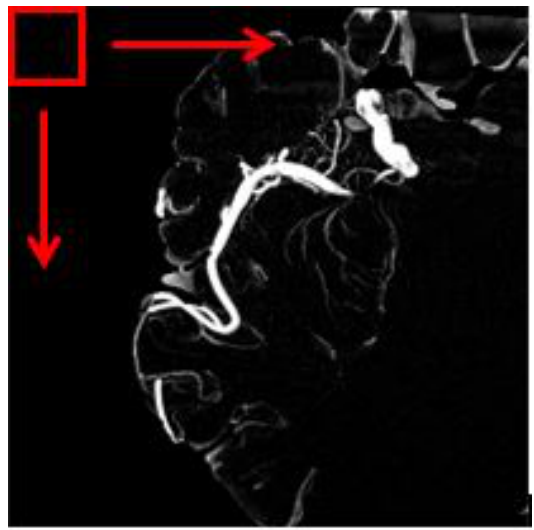
Figure 5. The red square represents the windowing